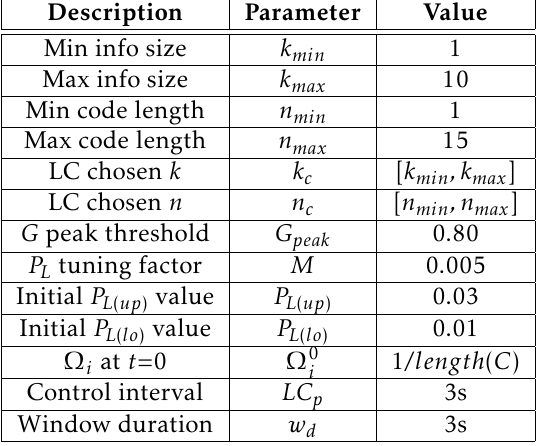
Table 3. Simulation and tuning parameters for the LC algorithm